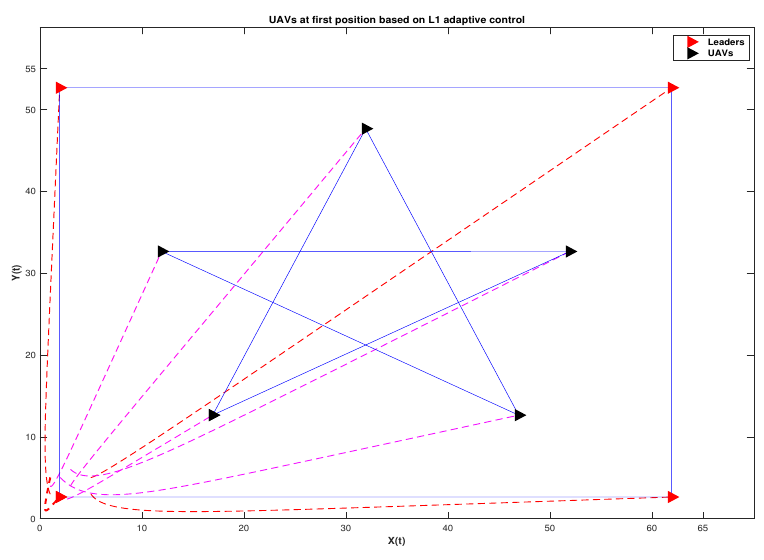
Figure 5. UAVs containment at the first position based on L 1 adaptive control without parameters uncertain.